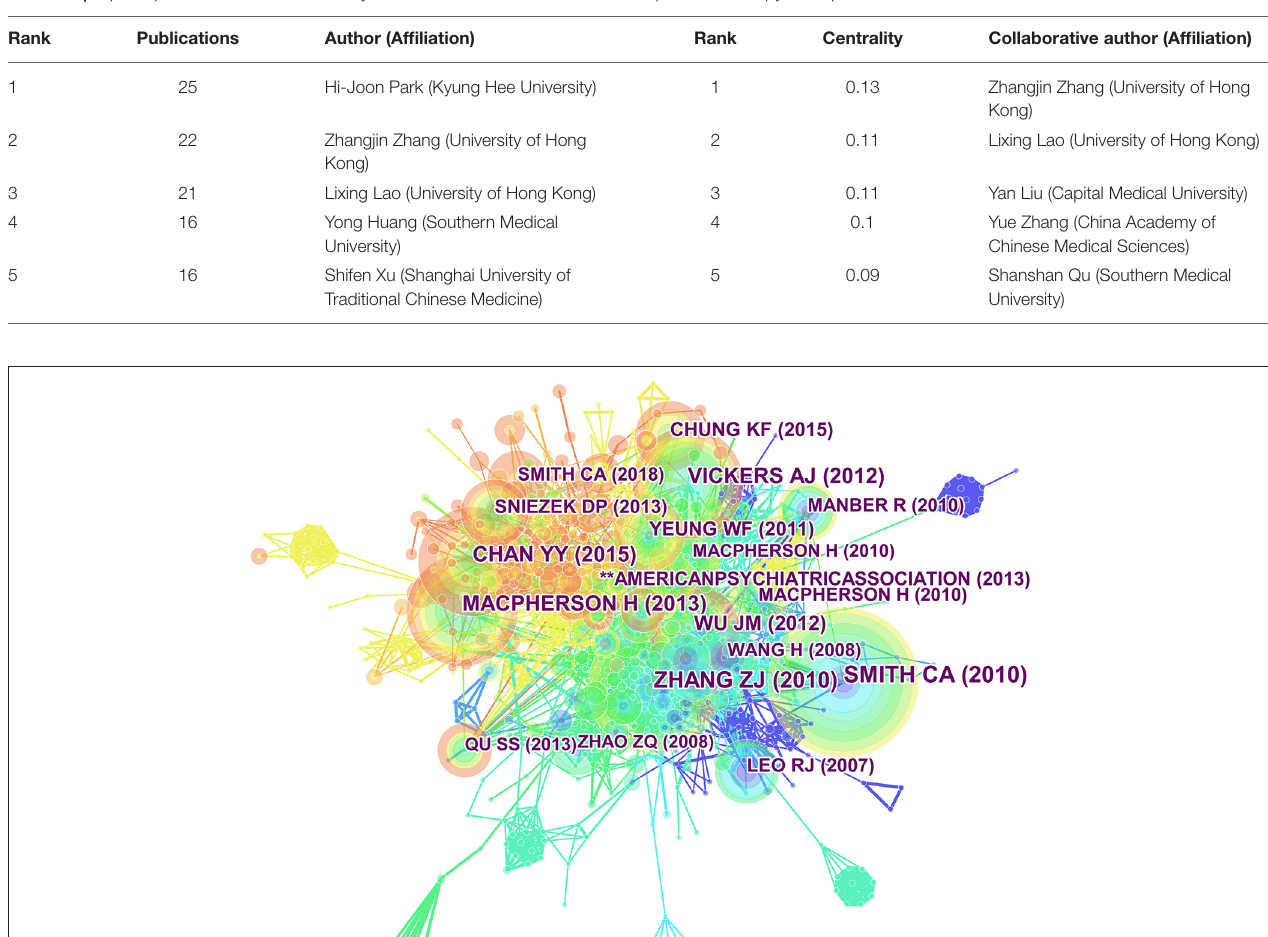
symptom severity may be different (Zhang et al., 2020b). In